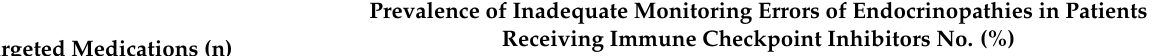
Table 2. Prevalence of Monitoring Errors of Endocrinopathies in Patients Receiving Immune Check- point